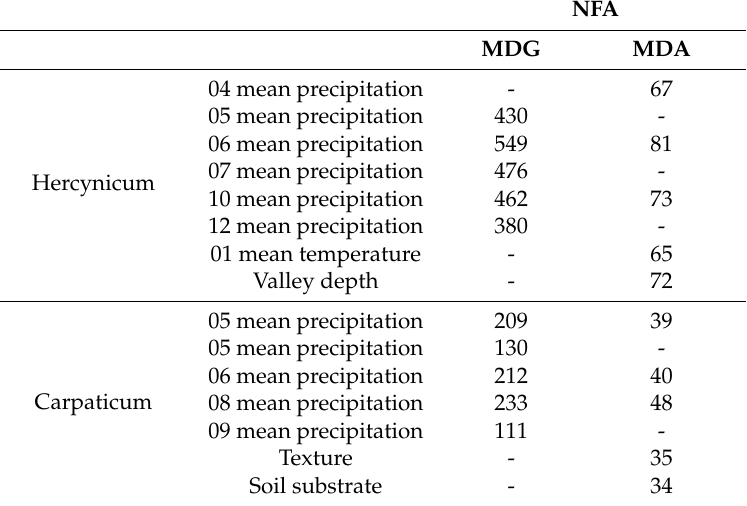
Table 2. The best Random Forests (RF) predictors of NFA based on both Mean Decrease Gini (MDG) and Mean Decrease Accuracy (MDA) for Hercynicum and Carpaticum.